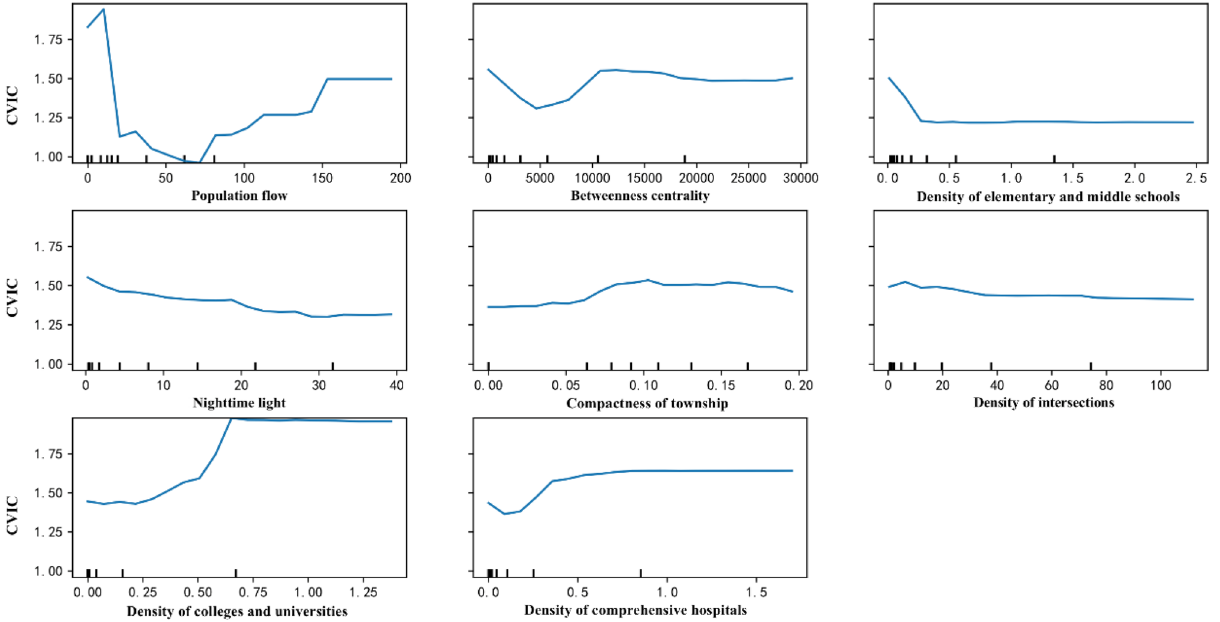
Figure 5. Partial dependence plot between built environment factors and the CVIC. Created using Anaconda Navigator Version 1.9.12 from Anaconda (https:// www. anaco nda.